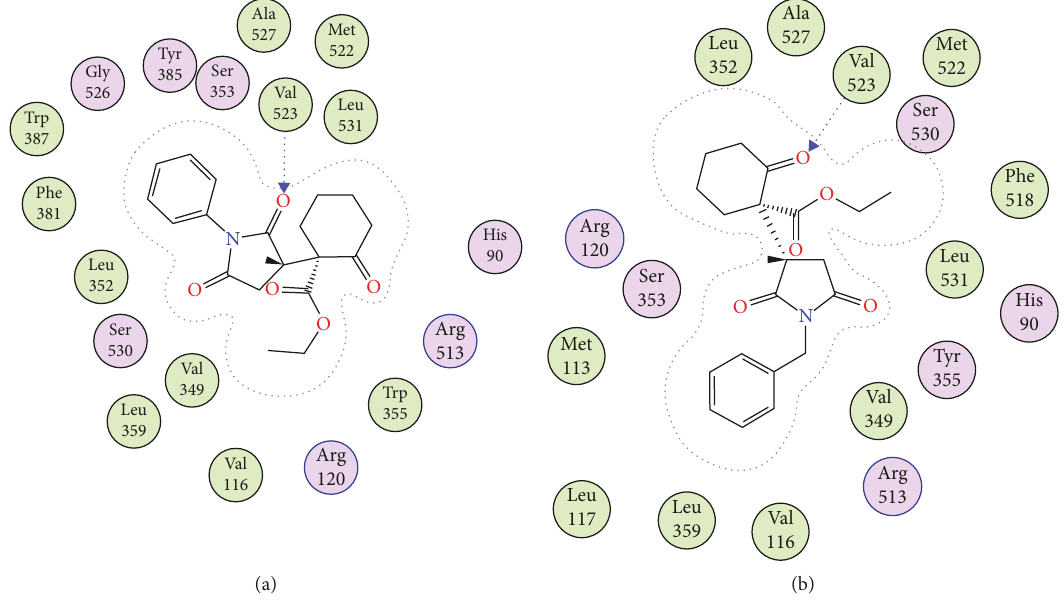
Figure 8: 2D (two-dimensional) binding interaction pattern of compounds (a) C and (b) D in the binding site of 1CX2.